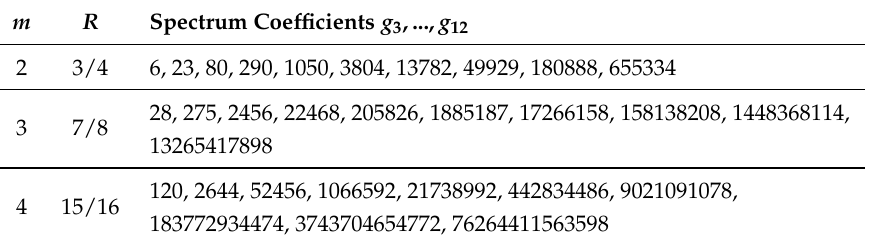
Table 1. Weight enumerators for Wyner–Ash